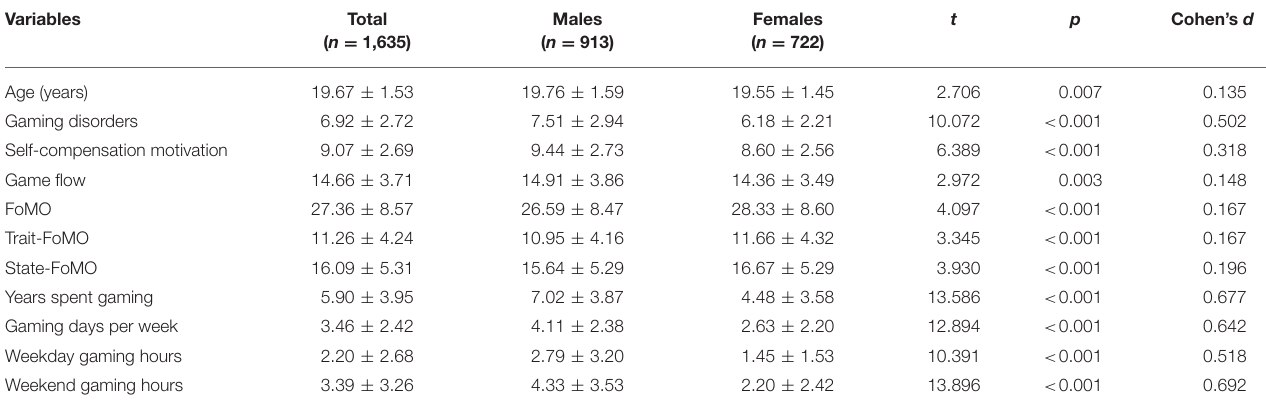
TABLE 1 | Descriptive characteristics of the sample ( n =